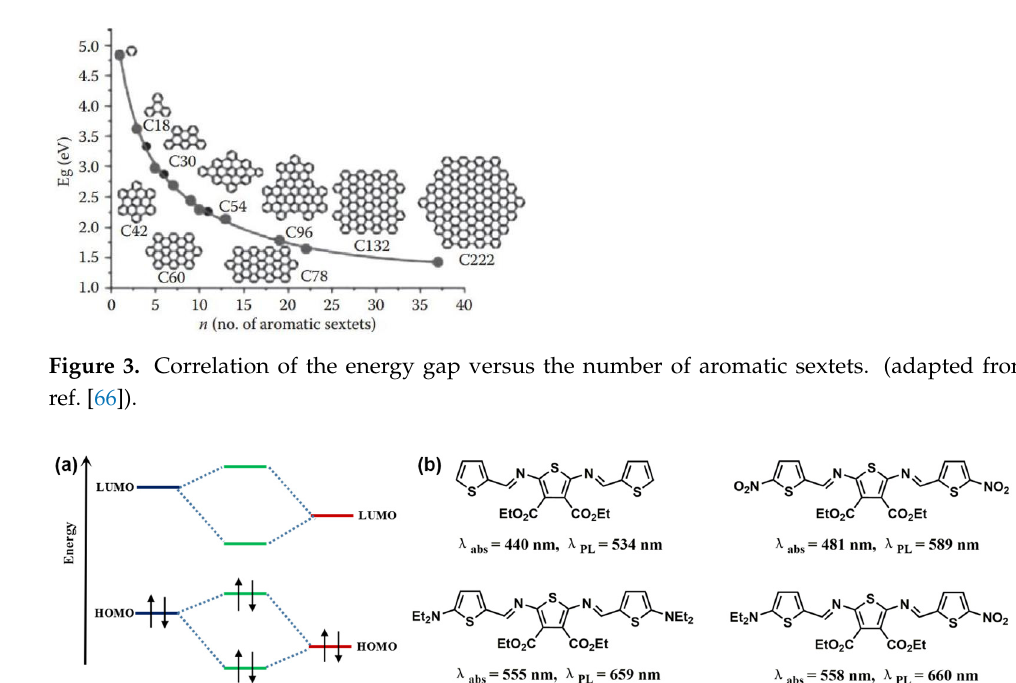
Figure 2. Absorption spectra of the entire tetraphenoxy-substituted rylenediimide series in CHCl 3 (adapted from ref. [65]).